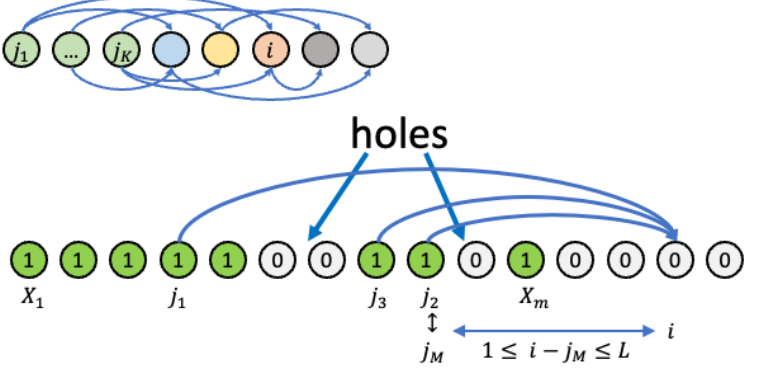
Figure 2. The linear scaffolding model. In this version, there are no well-defined levels. Known items are denoted by ones in a linear array of elements ( X ), and unknown ones by zeros. The “highest” known item is at position m . New items ( i ) become known ( X i = 1) if all random prerequisites j k are known. The maximum knowledge jump L limits the choice of i so that 1 ≤ i − j M ≤ L , where j M is the highest of prerequisites j k . In the figure, the proposed new item i is based on prerequisites j 1 , j 2 = J M , and j 3 ( K =